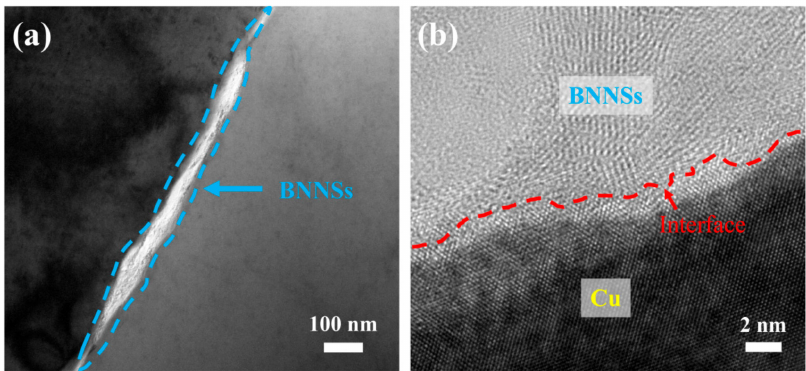
Figure 6. ( a ) TEM image and ( b ) HRTEM image showing the interface.